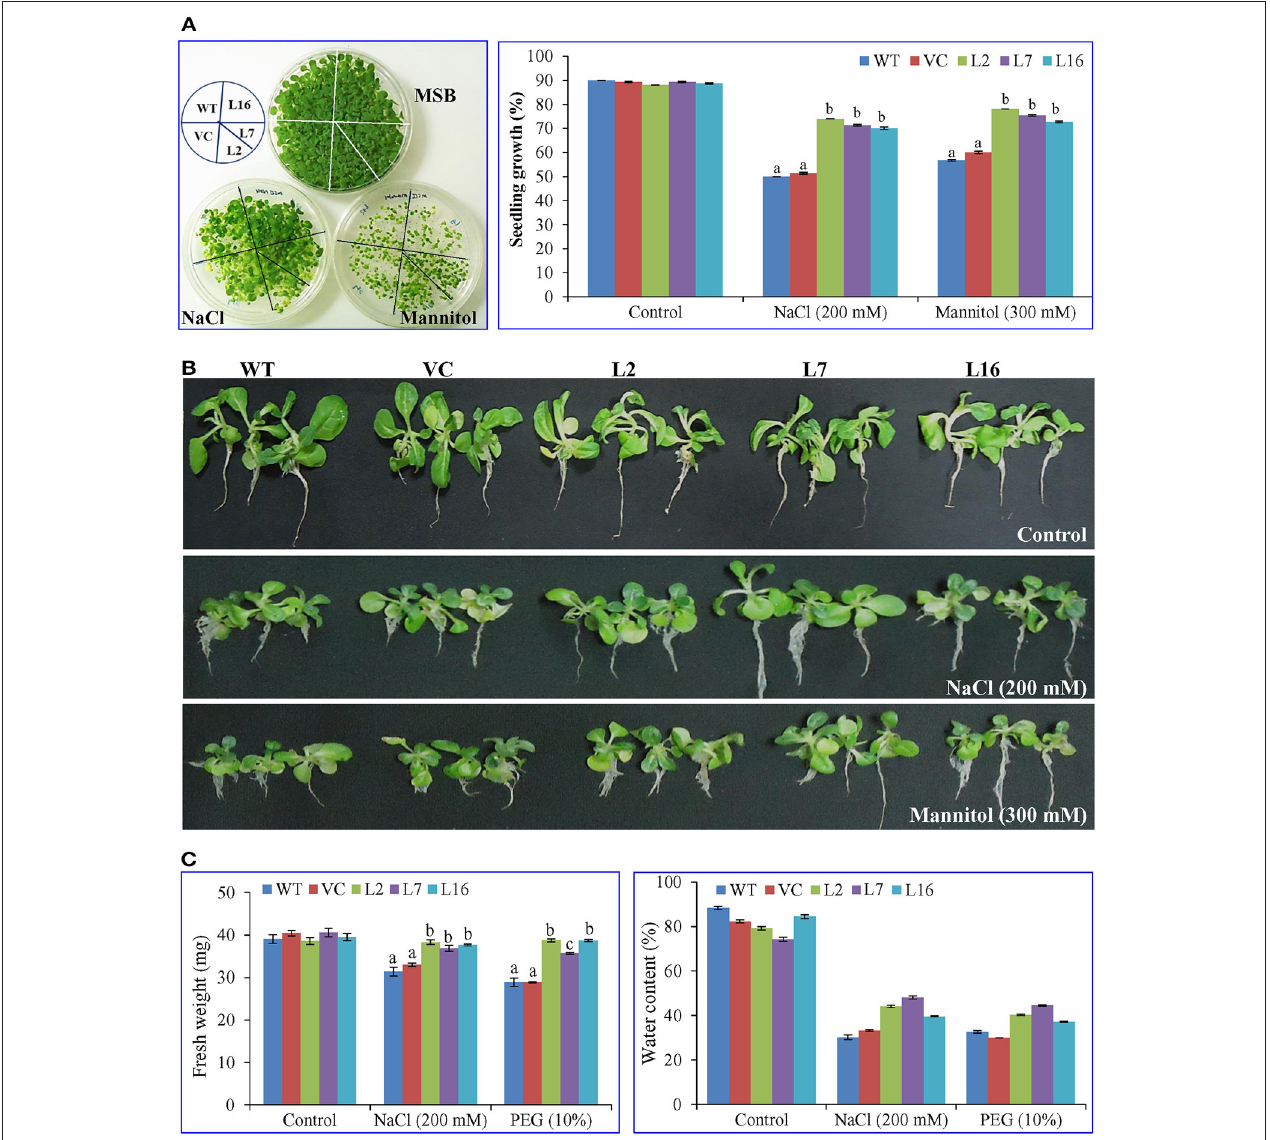
FIGURE 2 | Plant growth analyses of transgenic tobacco plants under abiotic stress. (A) Calculation of seedling growth percentage after 21 days. Comparative study of (B) morphology and (C) fresh weight and water content of transgenic lines (L2, L7, and L16) and control plants (WT and VC), grown for 21 days under salt and osmotic stress. Bars represent means ± SE and values with different letters are significant at P <